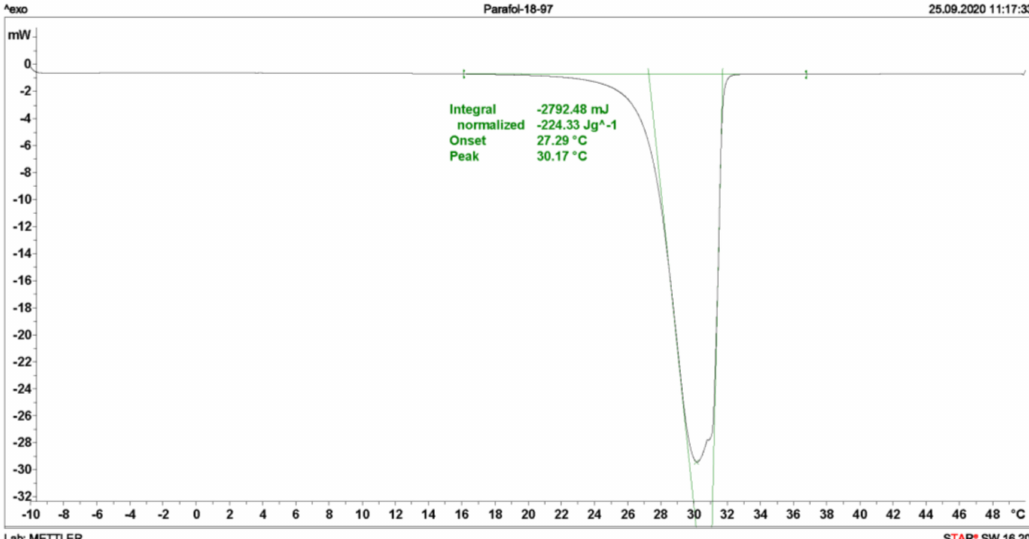
Figure 2. Graphical example of the determination of enthalpy, the integral of the signal with respect to the baseline before and after the peak, onset, as intersection between baseline and green tangential on the left, and peak, as highest point of the